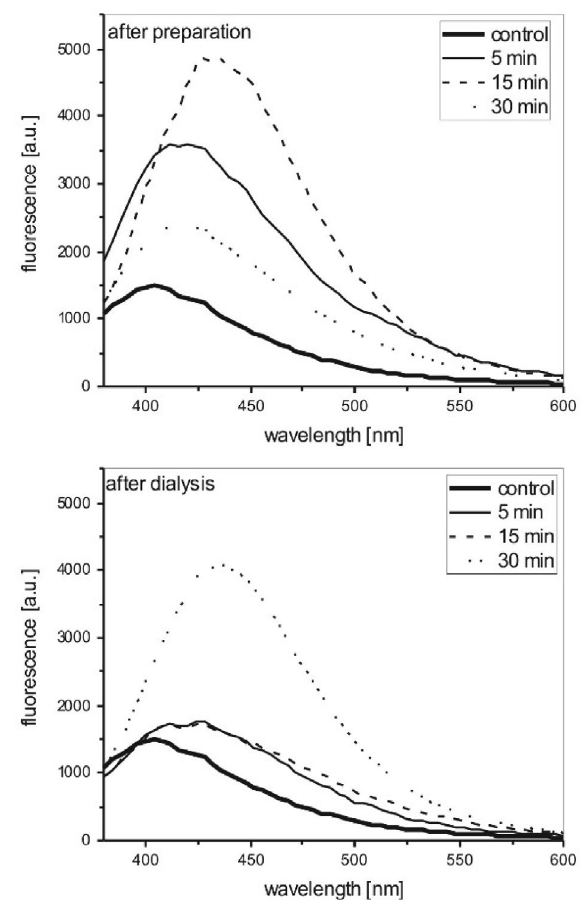
Figure 7. Fluorescence emission spectra of the prepared solutions. For activation light with 360 nm is used. Presented are spectra from solutions prepared with different process duration under a process temperature of 140